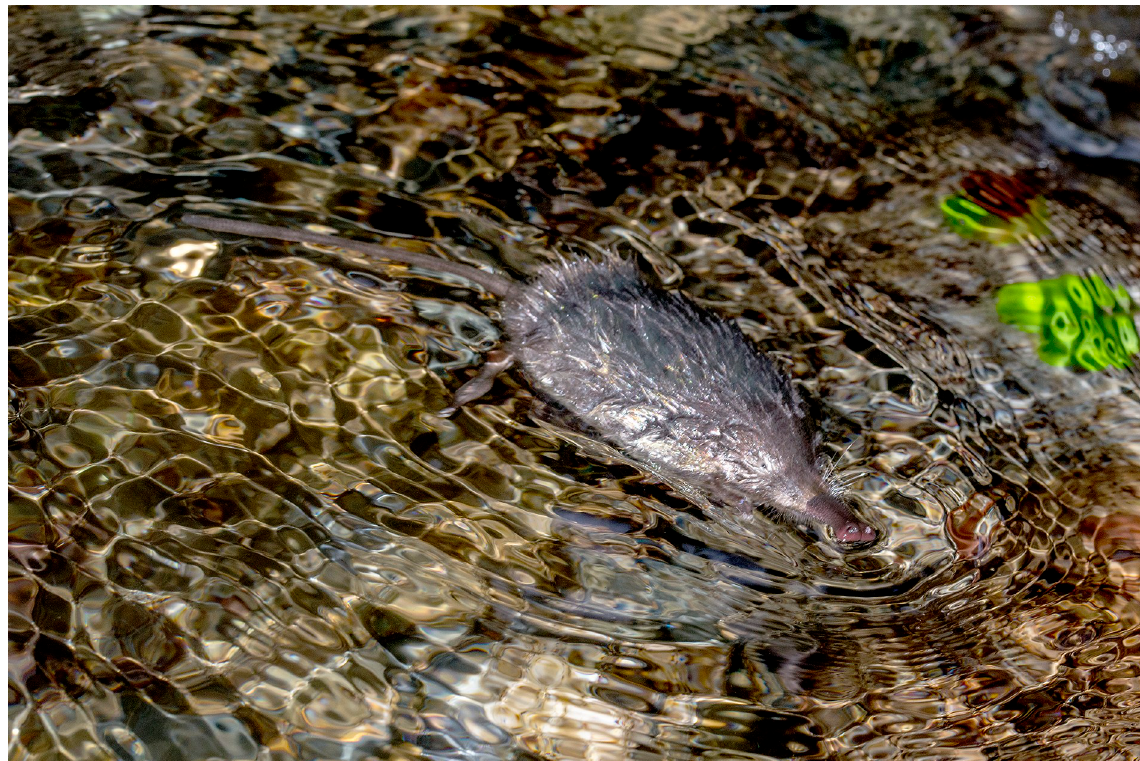
Fig 1. A Pyrenean desman in the Elama Stream. Photo by Joxerra Aihartza.